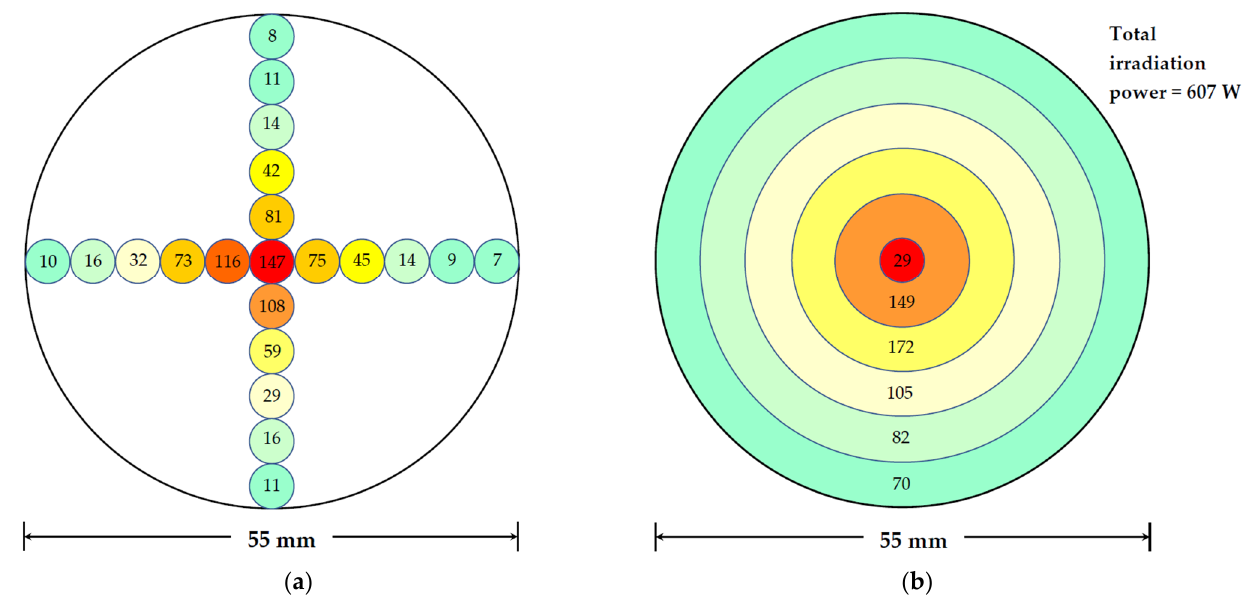
Figure 7. Scheme showing: ( a ) positions where measurements with radiometer were carried out. Inside each circle, the value indicates the measured flux, in W·cm −2 ; ( b ) zones used to calculate the total power; using the attenuator no. 5, estimated average values of power (in W) for each of the zones are mentioned in the figure, as well as the total power (607 W).